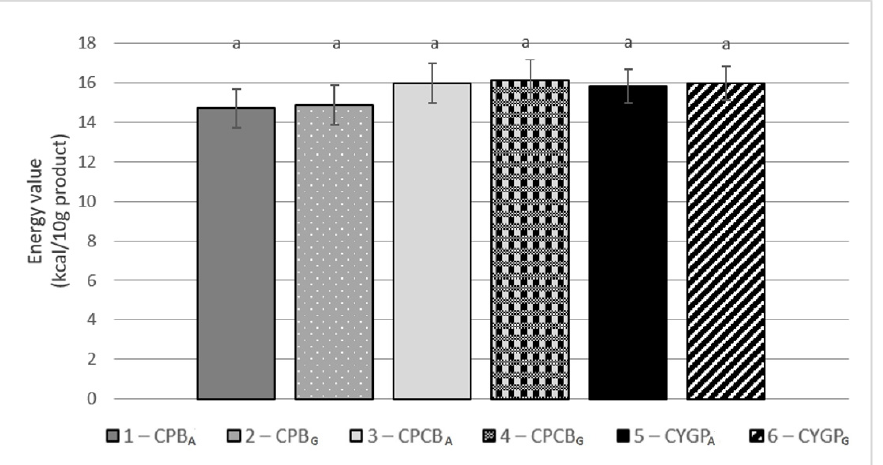
Figure 1. Average energy value of freeze-dried vegetable-based products produced with hydrocol- loids. The same letters (a) in individual columns indicate the absence of a statistically significant difference between the samples (significance level 0.05). Table 1. Index (A) next to the formulations symbol—formulations with sodium alginate and calcium lactate, index (G) next to the formulations symbol—formulations with the mixture of locust bean gum and xanthan gum.